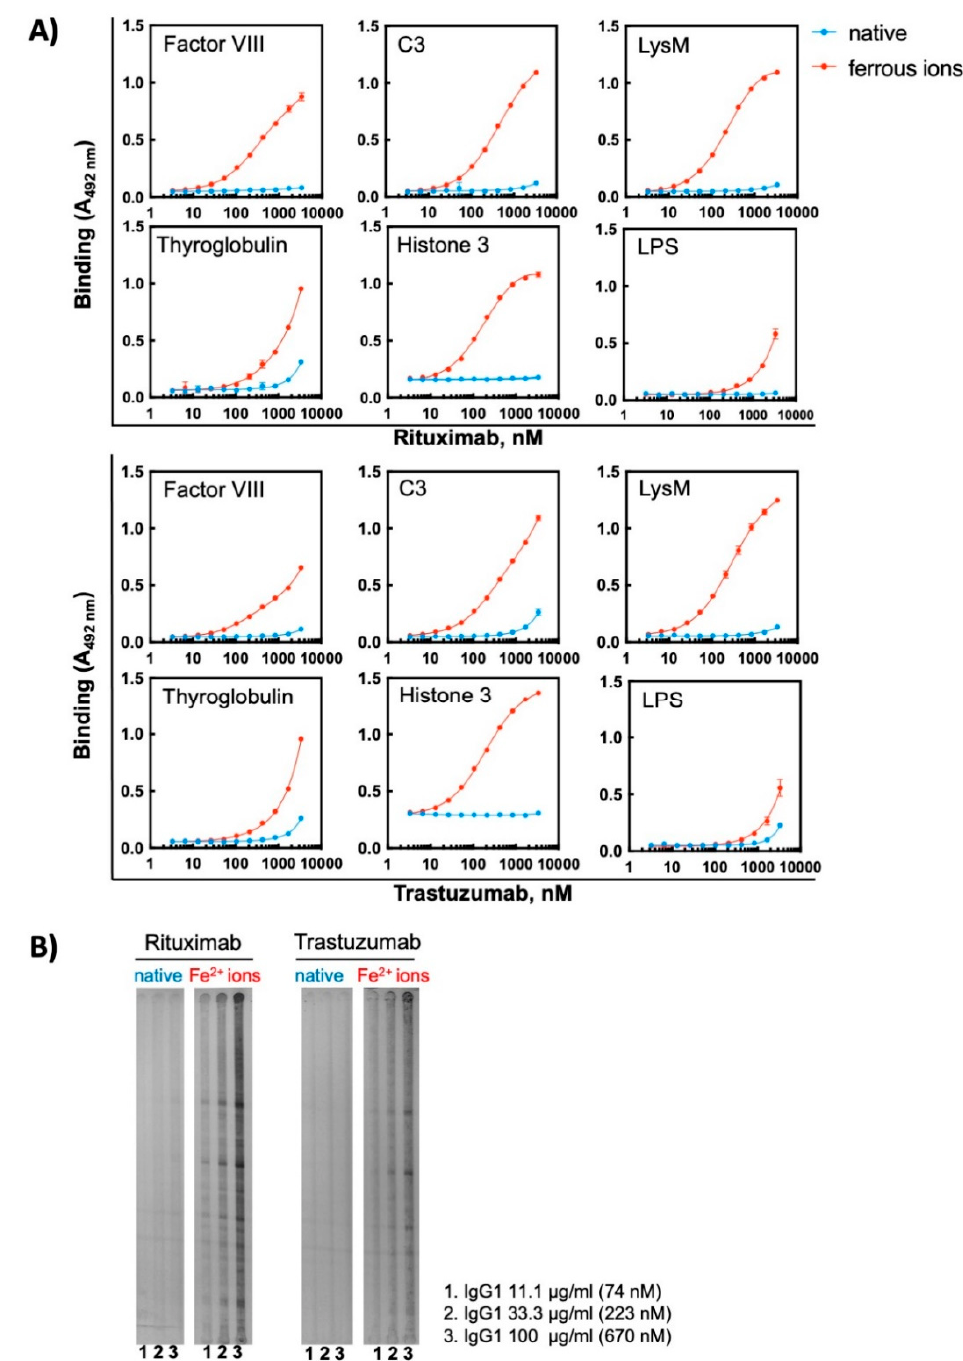
Figure 4. Treatment of therapeutic Abs—Rituximab and Trastuzumab—with ferrous ions results in induction of antigen-binding polyreactivity. ( A ) ELISA assay was used to evaluate the reactivity of native and Fe 2+ ion-exposed Rituximab or Trastuzumab. The Abs at 1 mg/mL (6.7 μ M) were treated with 500 μ M final concentration of FeSO 4 . After native and iron ion-treated Abs were serially diluted 3350—3.27 nM and incubated with the indicated proteins and LPS from E. coli immobilized on ELISA plates. Each symbol represents the averaged binding intensity obtained from triplicate samples ± SD. ( B ) Immunoblot analyses of reactivity of native and ferrous ion-exposed Rituximab and Trastuzumab to antigens from total lysate from Bacillus anthracis . Abs were treated at 1 mg/mL (6.7 μ M) with 500 μ M FeSO 4 . Next native and treated Abs were diluted to 100, 33 and 11 μ g/mL and incubated with the immobilized antigens using the Immunetics miniblot system.